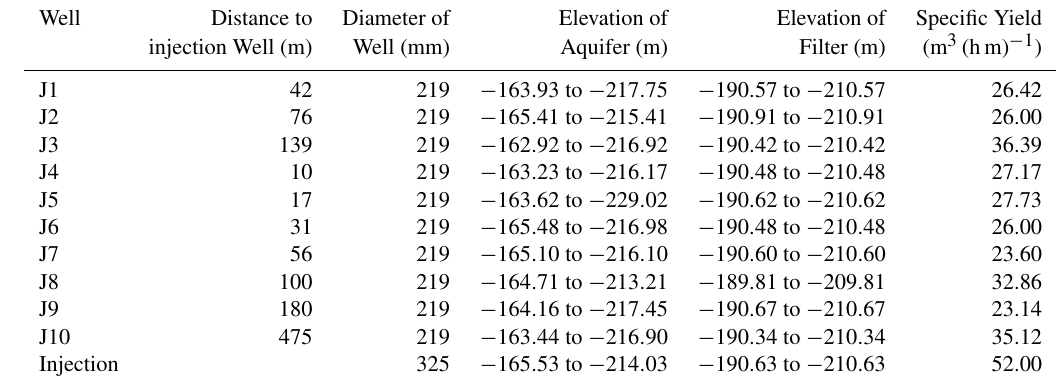
Table 1. Parameters of Monitoring and Injection Wells.